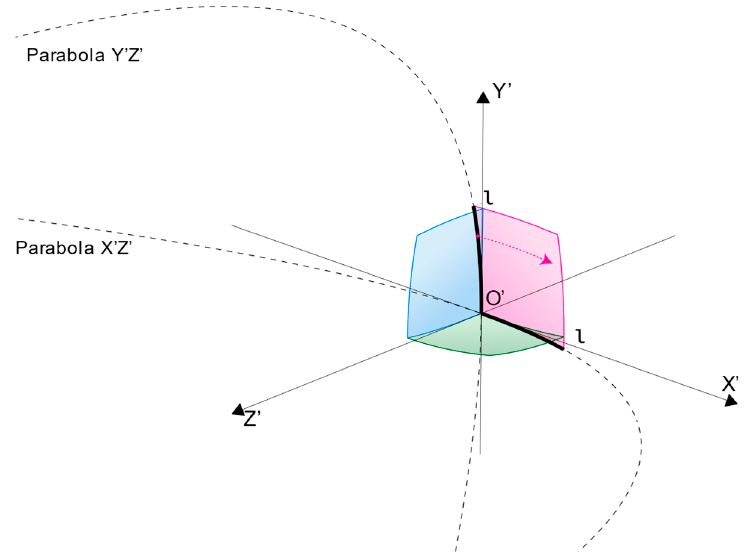
Figure A2. Geometry of a parabolic trihedron, showing how the pink face is formed by two parabolas. The other two faces are formed similarly.